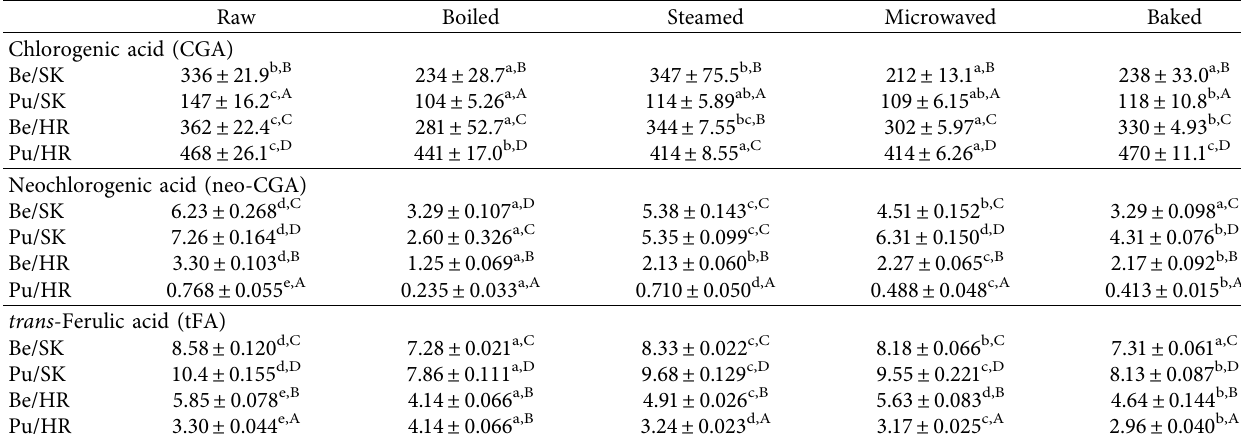
Table 6: Content of phenolics acid (mg/kg